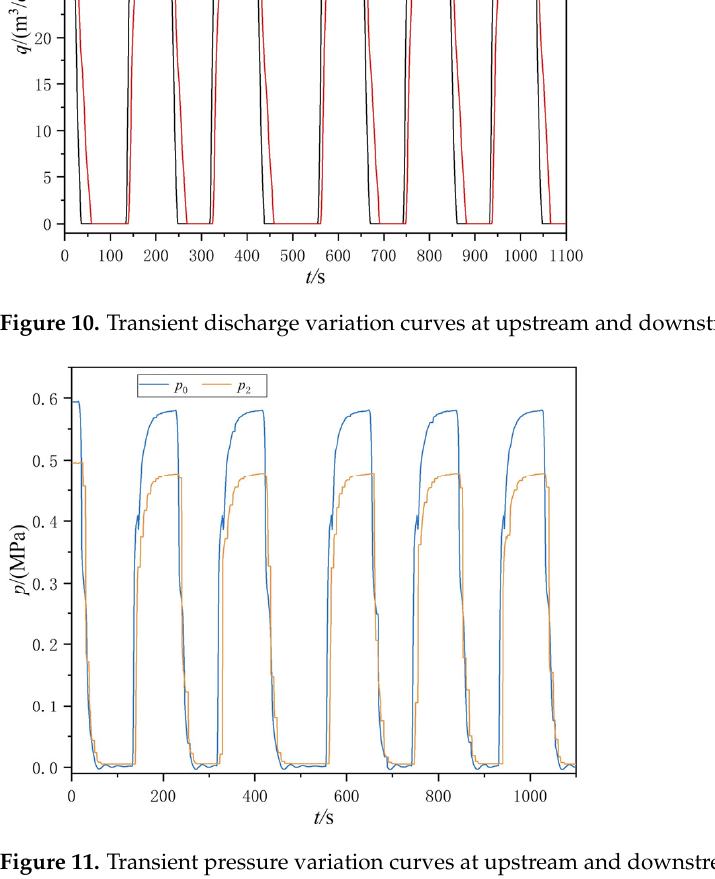
Figure 11. Transient pressure variation curves at upstream and downstream monitoring points.